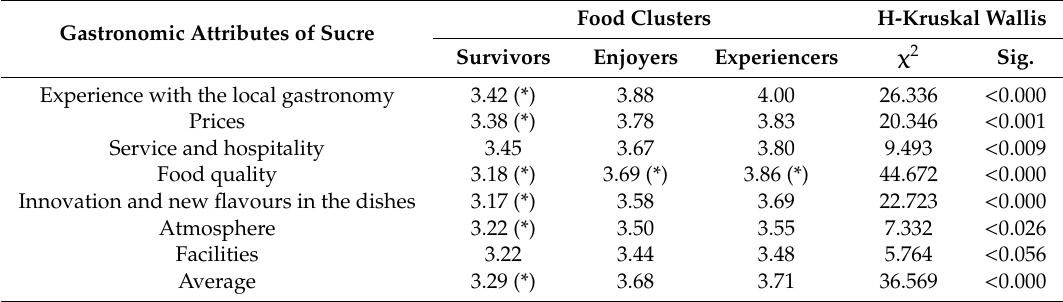
Table 5. Characterization of the clusters on relation to